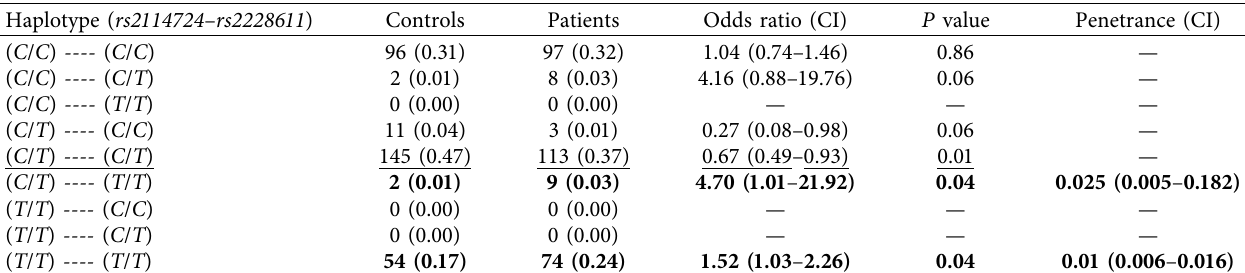
Table 3: Haplotype analysis of alleles at rs2114724 and rs2228611 in controls and schizophrenia patients. Haplotype ( rs2114724 – rs2228611